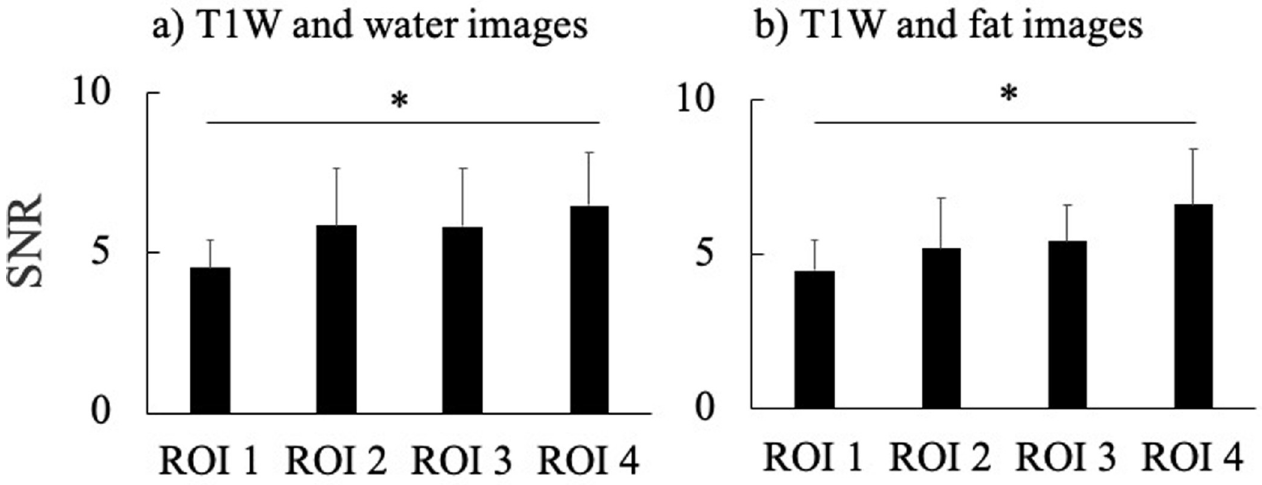
Fig 7. Difference of four corners in the signal-to-noise ratio (SNR) between T1-Weighted (T1W) and water images, and T1W and fat images. � P < 0.05, vs. regions of interest (ROI) 1.